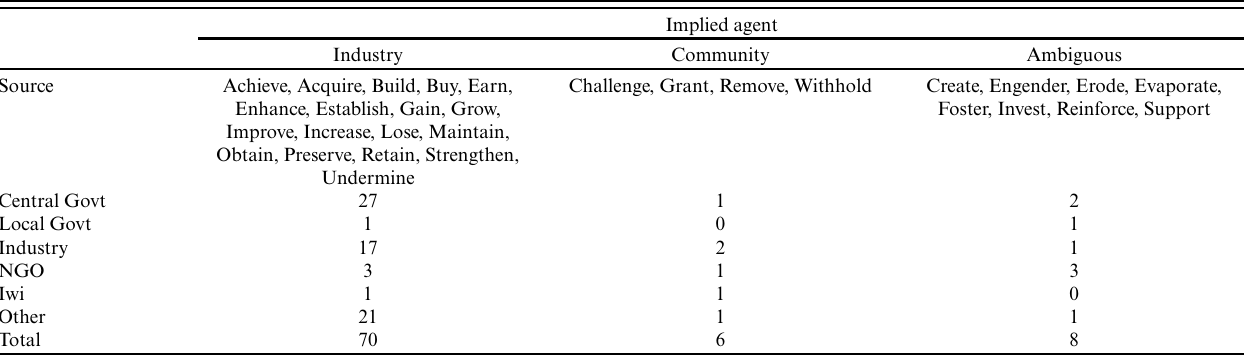
Table 4 . Instances of implied social license to operate (SLO) agency as revealed by material process verbs. Iwi = Indigenous M ā ori tribes of New Zealand